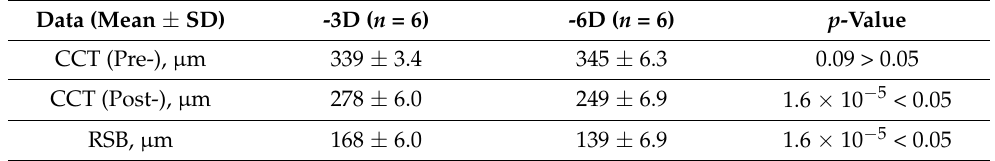
Table 1. Central corneal thickness before and after the SMILE surgery.